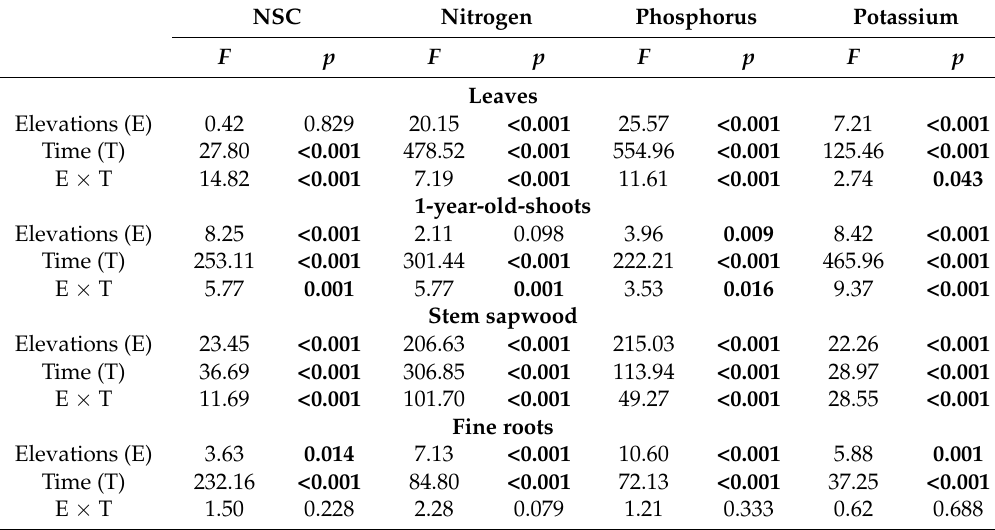
Table 2. Results of two-way nested ANOVAs with elevation and time as fixed factors. F and p values are given. NSC = Non-structural